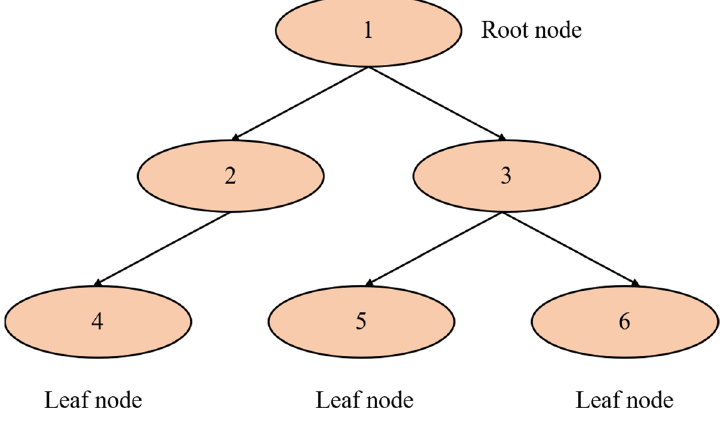
Figure 3. Decision